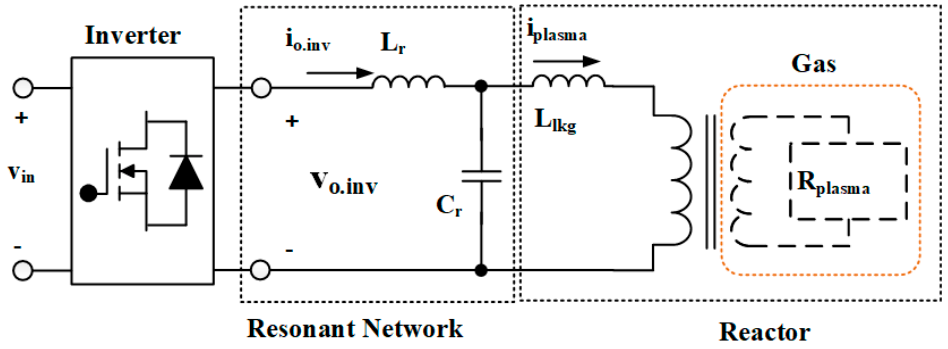
Figure 1. Conceptual circuit diagram of the plasma generation system.